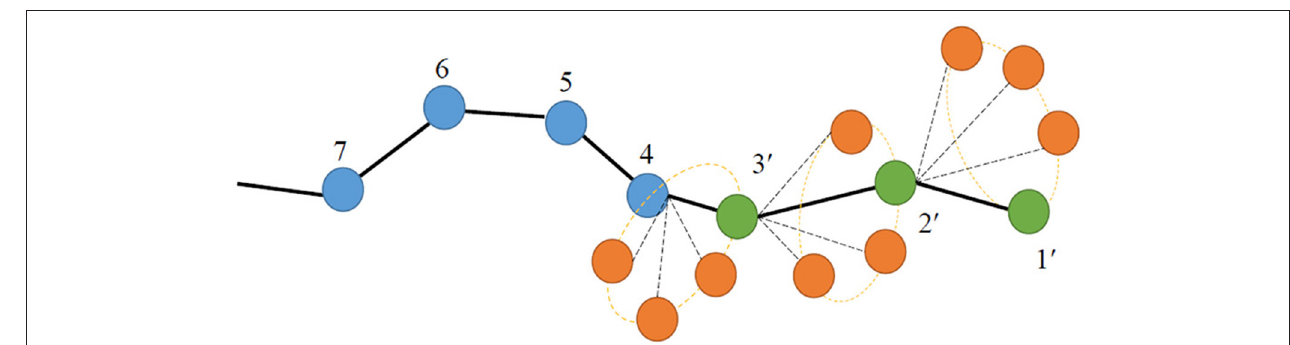
FIGURE 2 | Schematic illustration of the configurational bias Monte Carlo move for polymer simulations in continuous space.